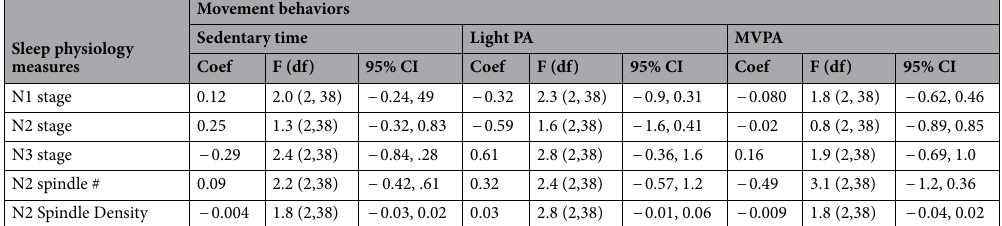
Table 2. Linear regression results for associations between movement behaviors and nap sleep stages. Linear regression models were adjusted for age. df degrees of freedom, CI confidence intervals, PA physical activity, MVPA moderate- to vigorous-intensity physical activity.